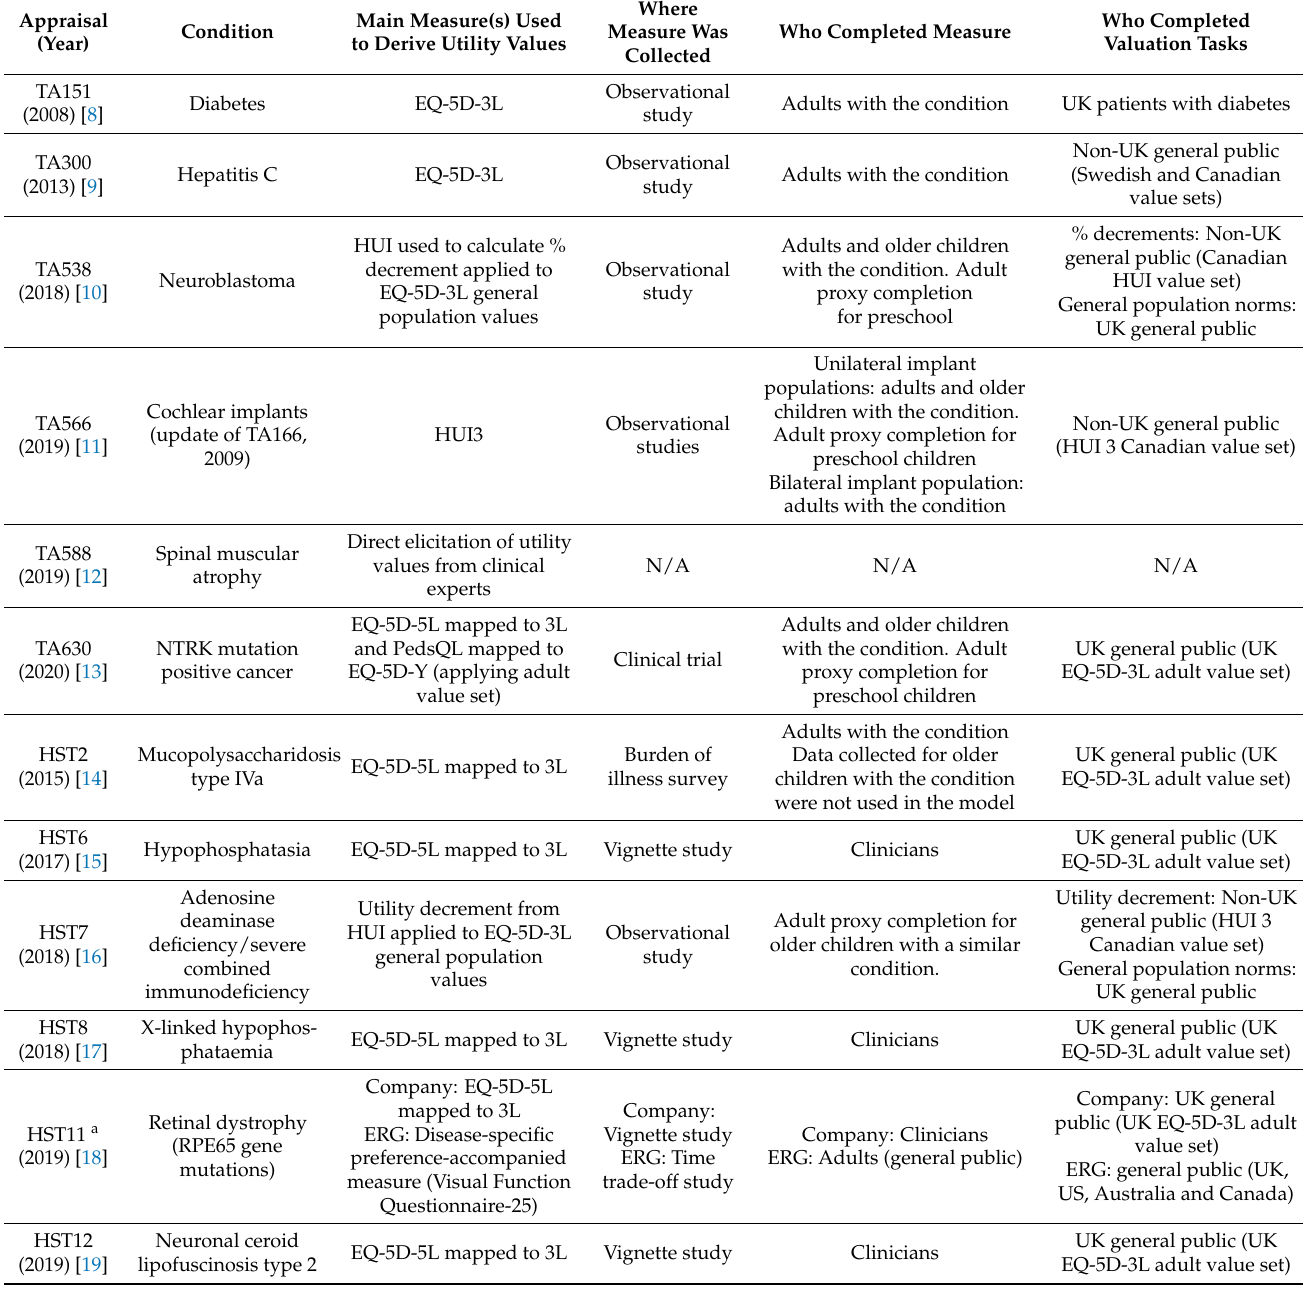
Table 1. Methods used to measure and value quality of life in NICE appraisals that included preschool